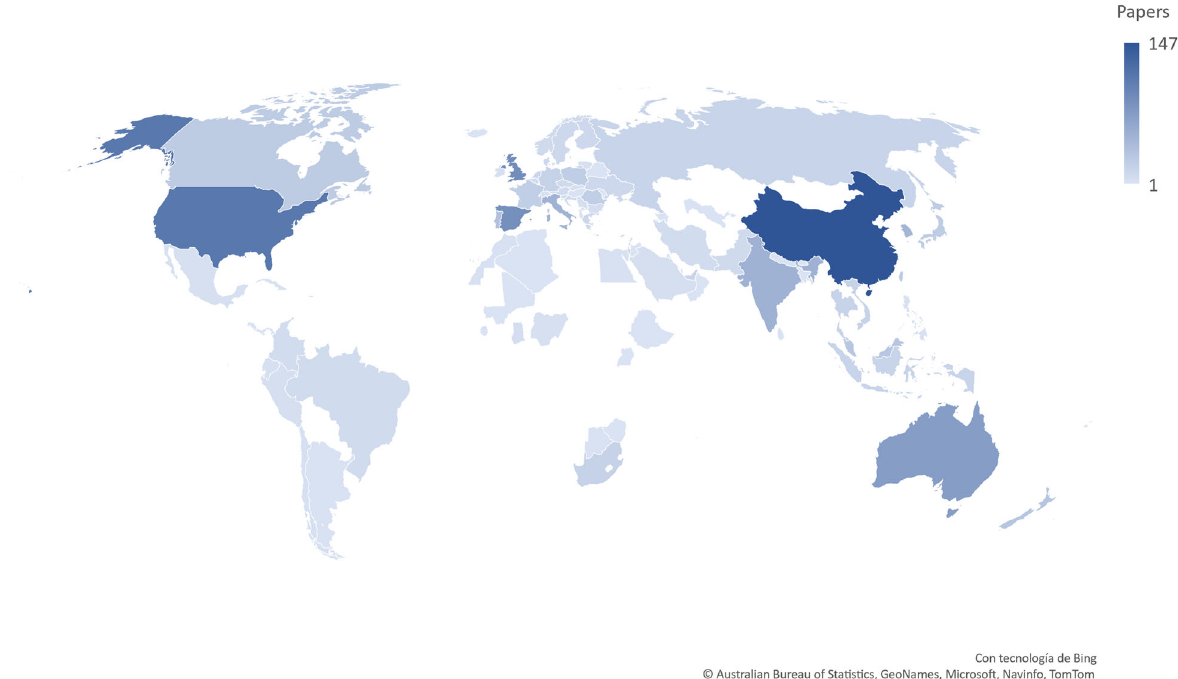
Fig. 5 Geographical distribution. Representation of articles about Covid-19 and